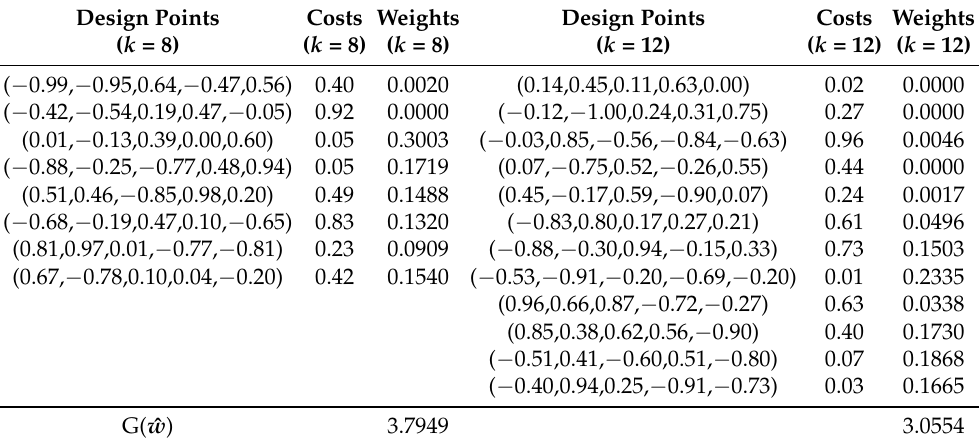
Table A3. Design points, costs, EA -optimal weights, and values of objective function (4) when p = 5.